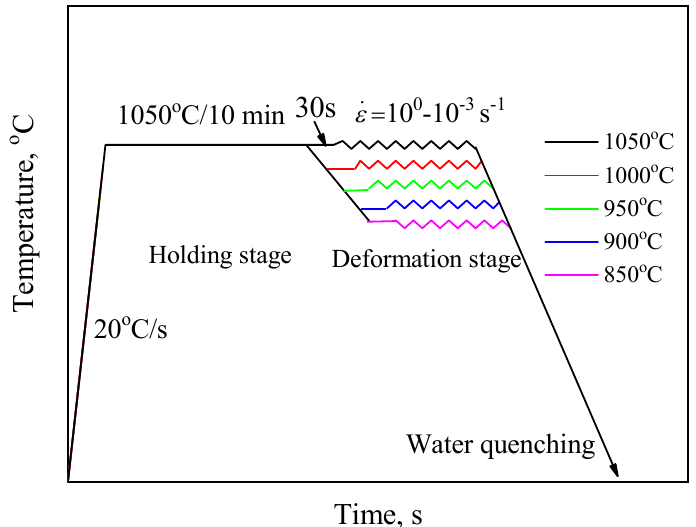
Figure 1. ( a ) Microstructure of the 47Zr-45Ti-5Al-3V alloy solution-treatment at 1050 °C for 0.5 h. ( b ) Initial microstructure simulated by CA.